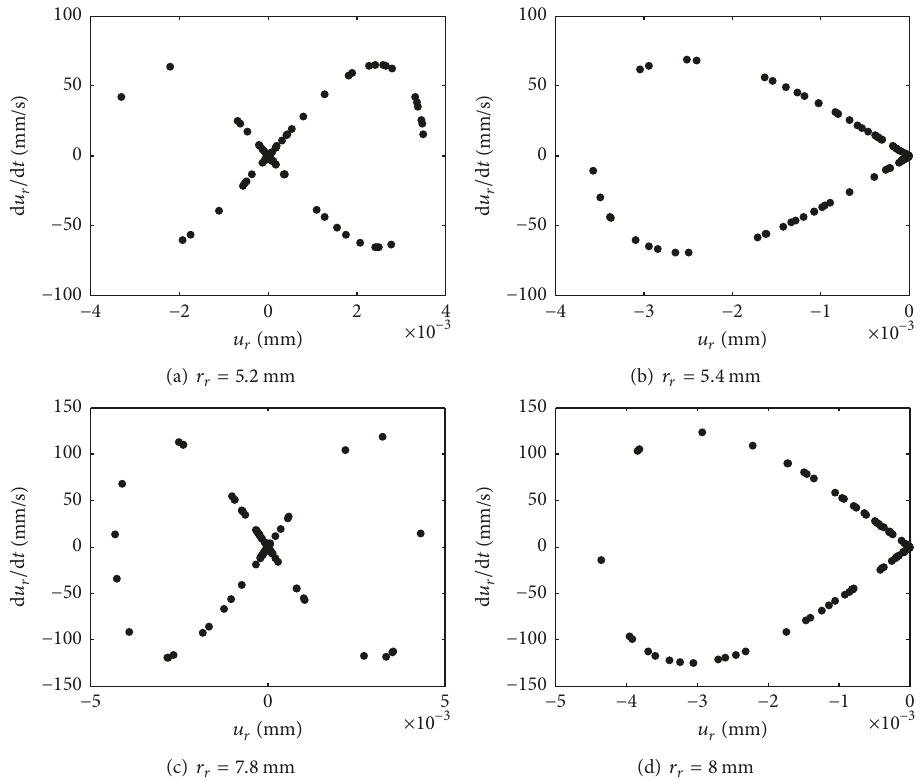
Figure 13: Poincare map of vibration response of rotor for different theoretical